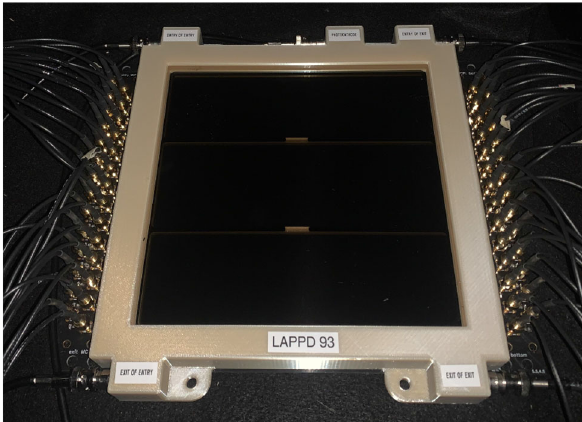
Fig. 1 Tile #93, fully cabled for the readout of 28 strips and to provide high voltage to the four MCPs and the photocathode. The sensitive area is about 380 cm